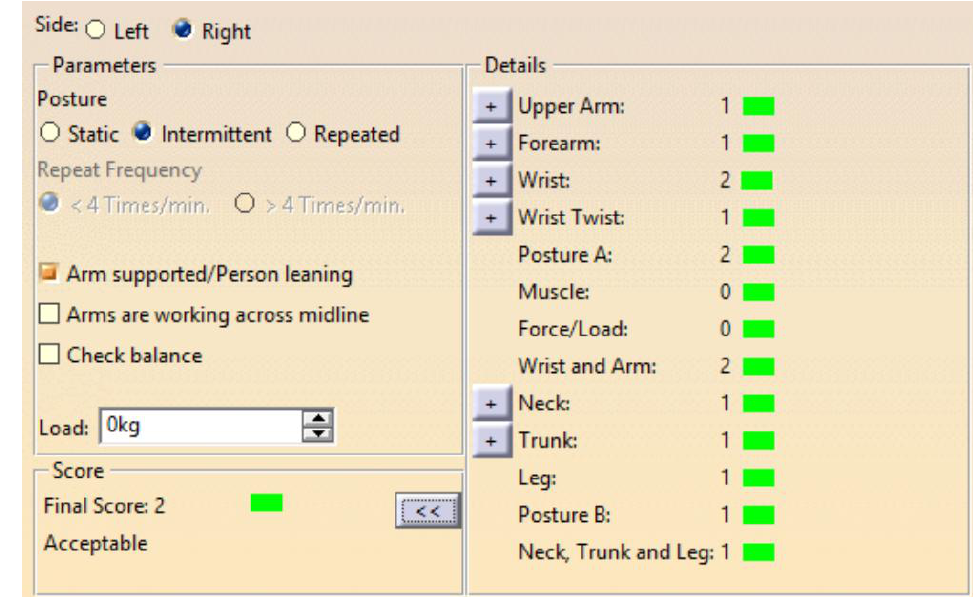
Figure 8. RULA analysis of the improved body